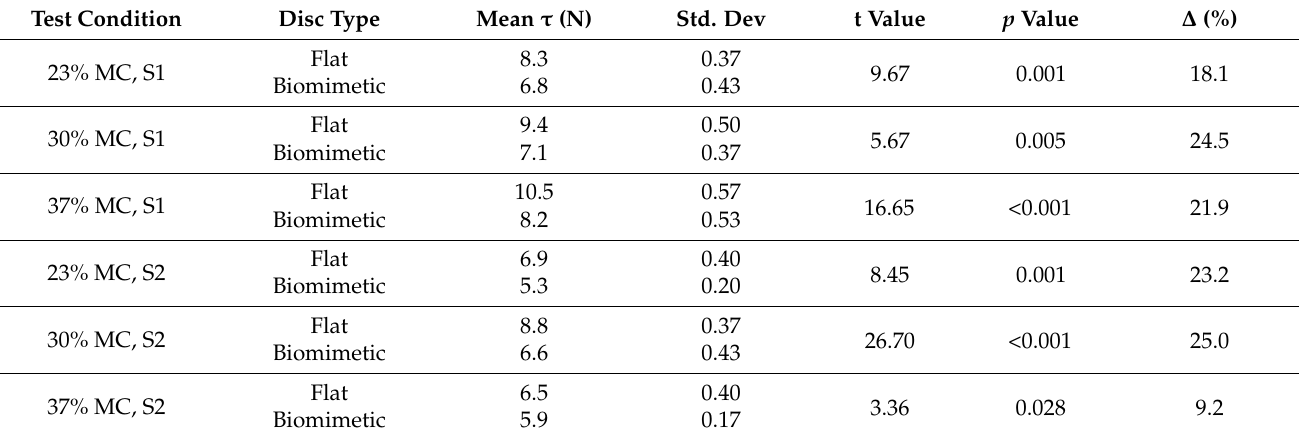
Table 6. Statistical analysis on the drag force of the flat disc against that of optimized biomimetic disc. Test